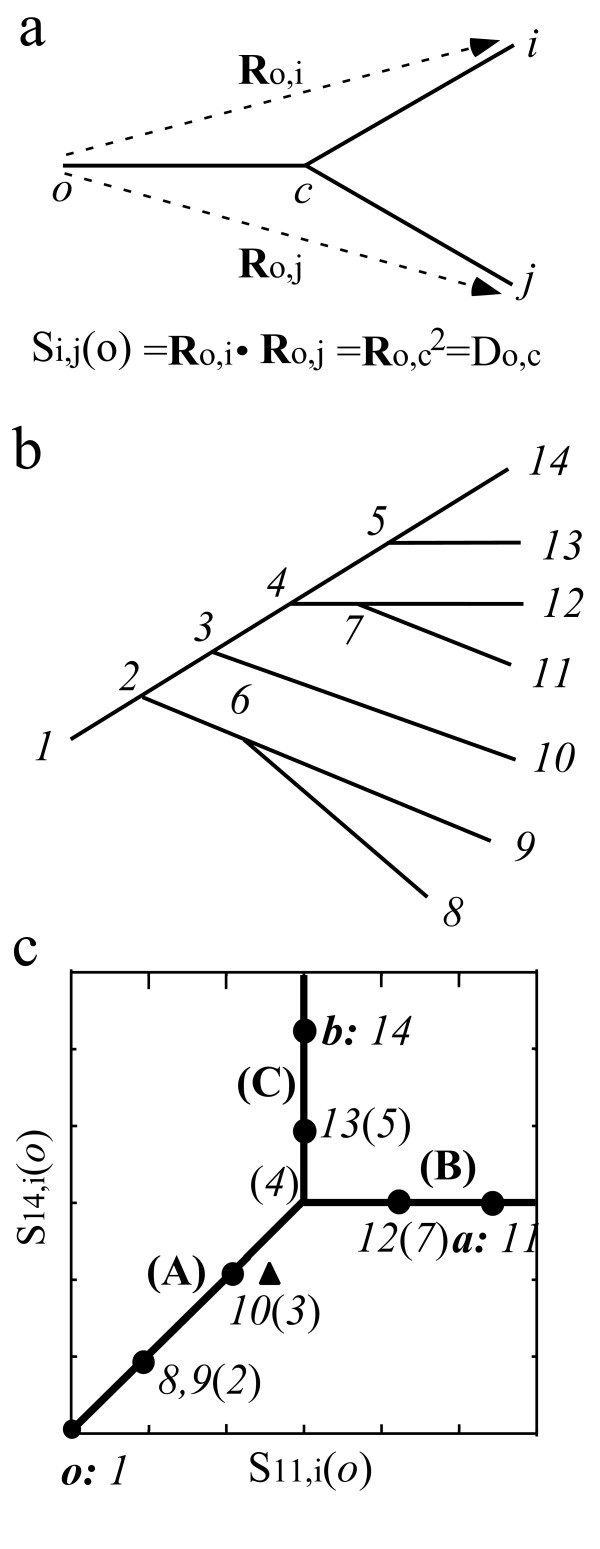
The MVS representation of a branching pattern. The distance Do, cbetween o and c is given by the inner product, Si, j(o), of two spatial vectors, Ro, i and Ro, jin MVS (Fig. 9a). The branching pattern of Fig. 9b and corresponding MVS representation of Fig. 9c in terms of S11, i(o) and S14, i(o). Here, the triplet of probes o = 1, a = 11, and b = 14 were used. The endpoints (8, 9), 10, 12, and 13 are degenerated into the positions of the nodes 2,3,7, and 5, respectively. When the pairwise differences satisfy orthogonality, the scatter plots are placed on the orthogonal lines A, B and C. Convergent evolution between the two branches (3→ 10) and (7→ 11) underestimates the pairwise difference between 10 and 11, causing a deviation of point 10 from the orthogonal line A, which moves it to the position of the triangle.